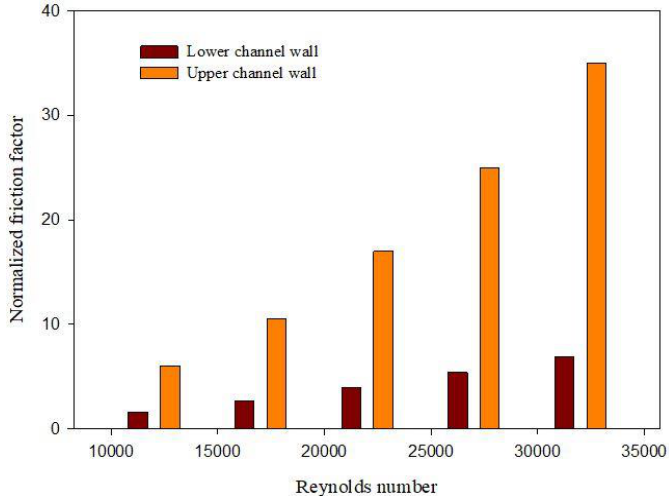
Figure 16. Dimensionless friction factor along with the exchanger vs. Re.